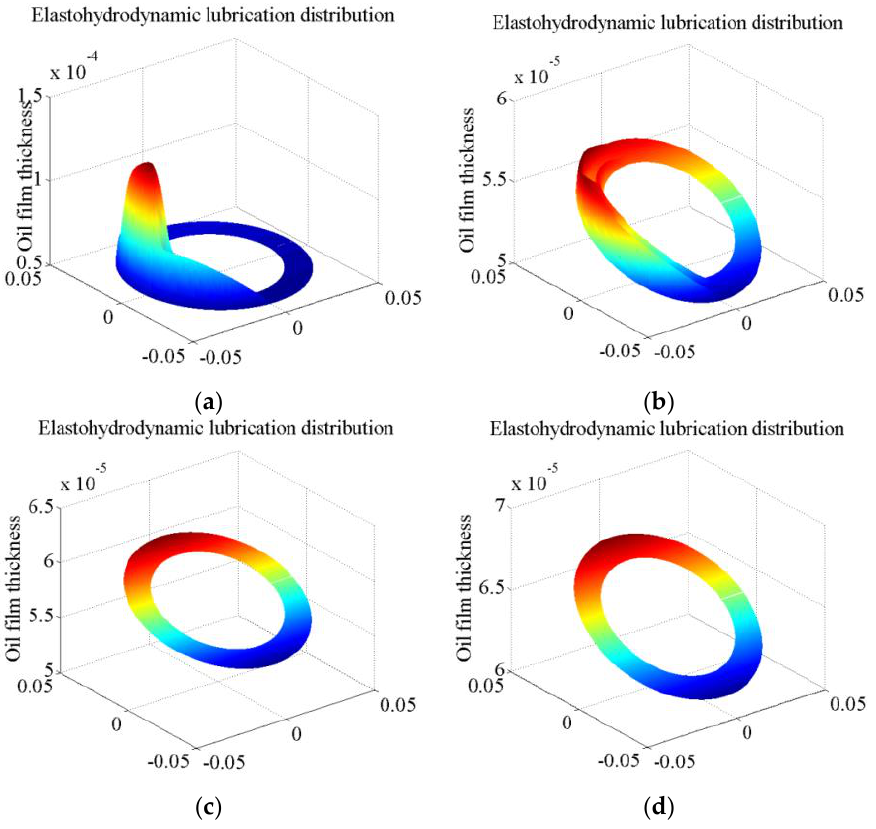
Figure 12. Effect of the initial oil film thicknesses on the oil film clearance under elastic deformation. ( a ) h 0 = 0.02 mm; ( b ) h 0 = 0.03 mm; ( c ) h 0 = 0.04 mm; ( d ) h 0 = 0.05 mm.